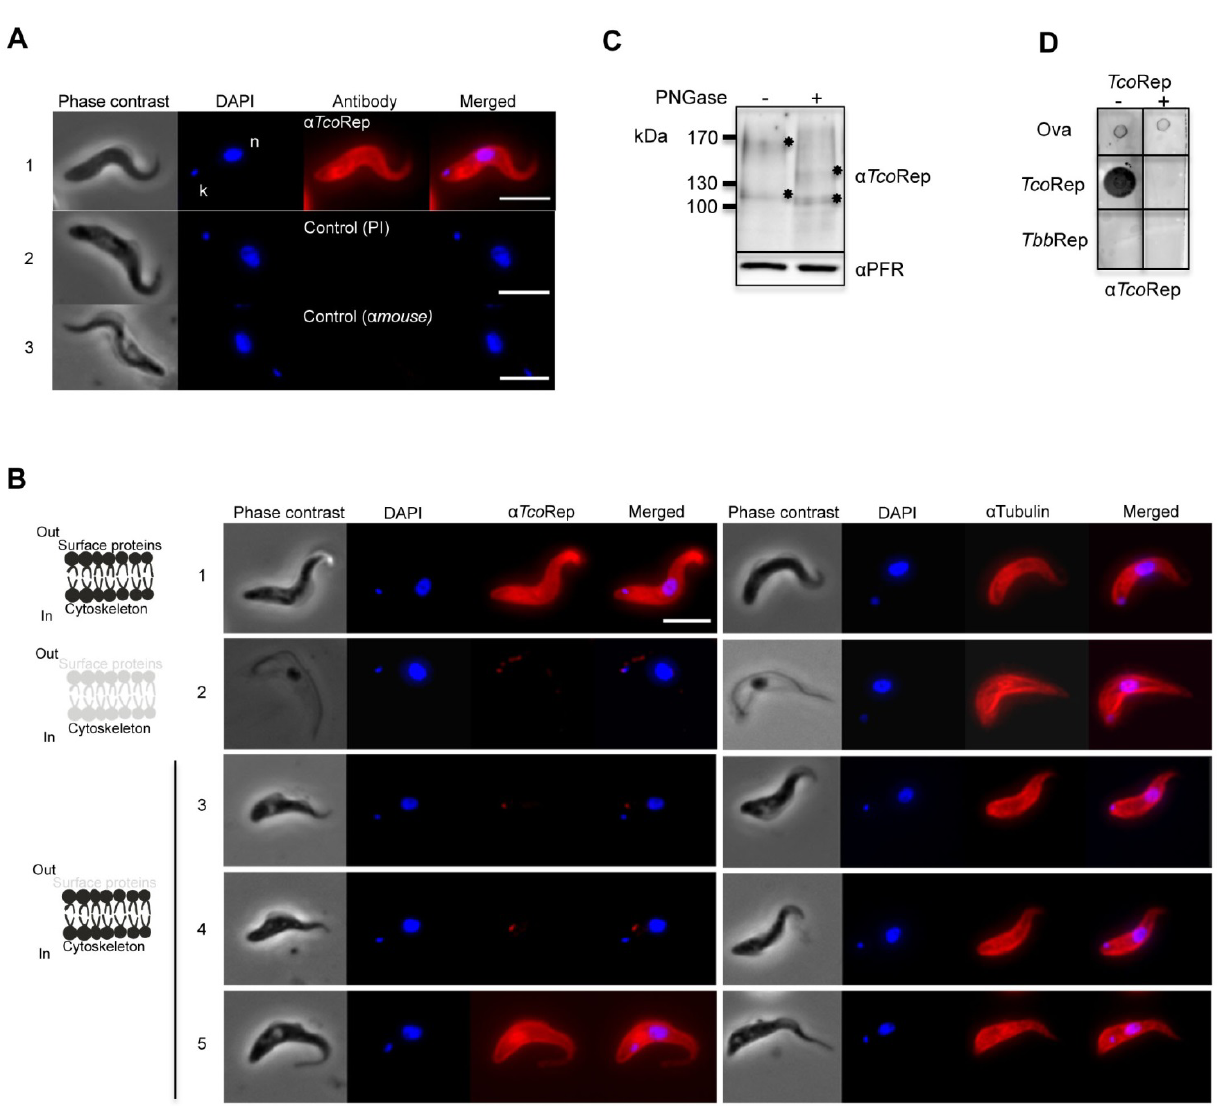
FIGURE 3: Expression and cellular localization of TcoClec in BSF of T. congolense . (A) Immunofluorescence analysis of T. congolense BSF. Cells were stained with mouse anti-TcoRep (1); control pre-immune serum (2); or secondary antibody alone (3). DAPI was used to stain both nucleus (n) and kinetoplast (k). Phase contrast images are shown on the left. (B) Immunofluorescence analysis. Images are typical examples showing phase contrast, DAPI staining of the nucleus and the kinetoplast, and staining with anti-TcoRep or anti-tubulin. Whole-cell T. congo- lense BSF (1); cytoskeleton-extracted cells (treated with NP40) (2); and trypsin-treated cells (« shaved » parasites) with IFA performed imme- diately (3), 5 h (4) and 14 h (5) after the treatment. A schematic illustration is shown on the left to explain the effects of the treatments on Tco BSF. Bar, 5 µm. (C) Western blot analysis. Tco BSF cell lysates treated (+) or not (-) with PNGase F. Mouse anti-TcoRep and rabbit anti-PFR (control) were used. Asterisks show band shifts. (D) Peptide competition assay (PCA). Dot blot analysis developed with anti-TcoRep antibod- ies. Anti-TcoRep antibodies were incubated (+) or not (-) with the TcoRep peptide. Ovalbumin (Ova), TcoRep peptide and TbbRep peptide were spotted on the